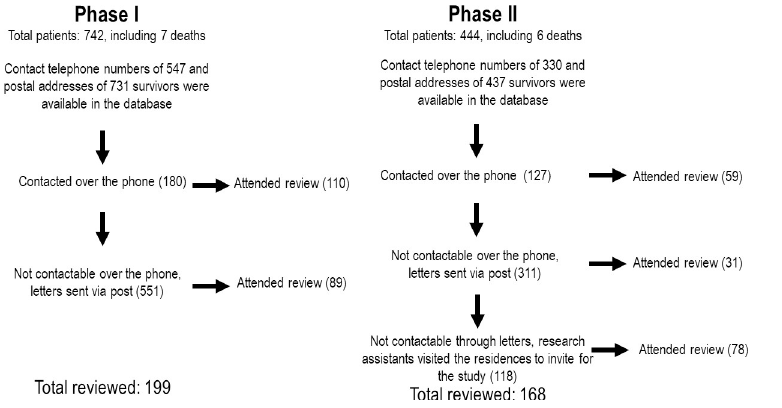
Fig 1. Patient recruitment for the